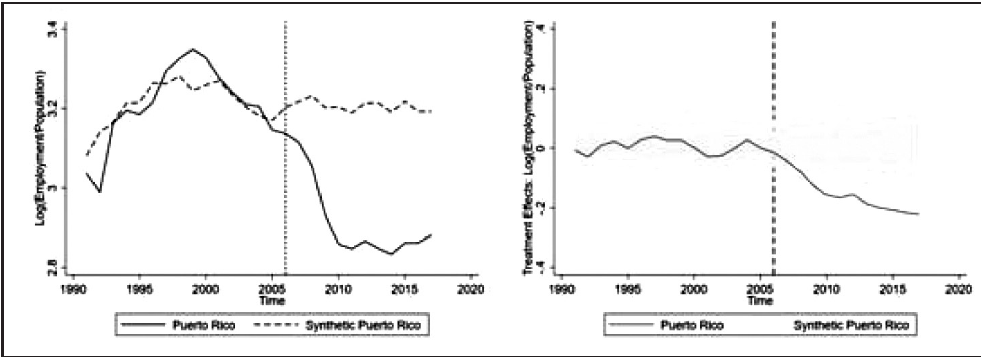
Treatment E effects and Placebo Test: Teen Employment (International